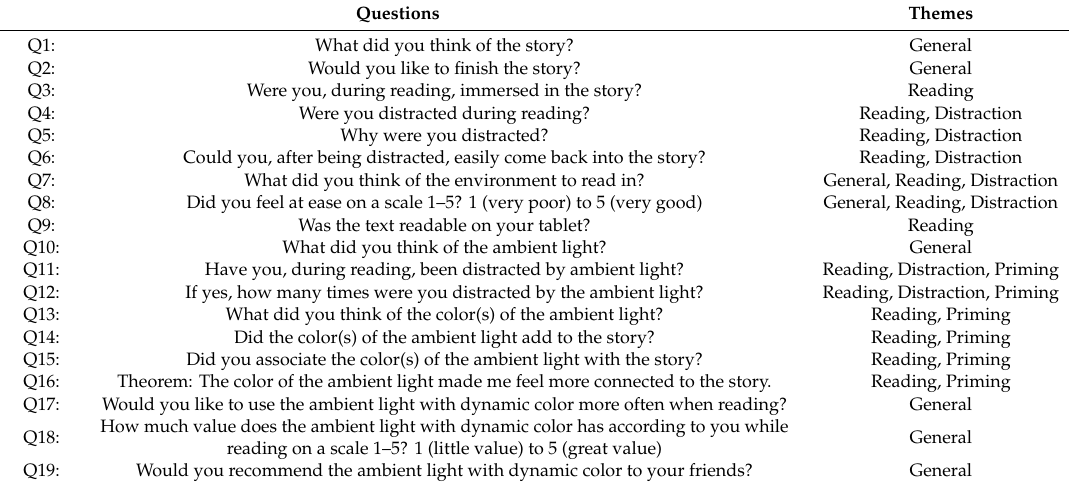
Table 1. Structured interview